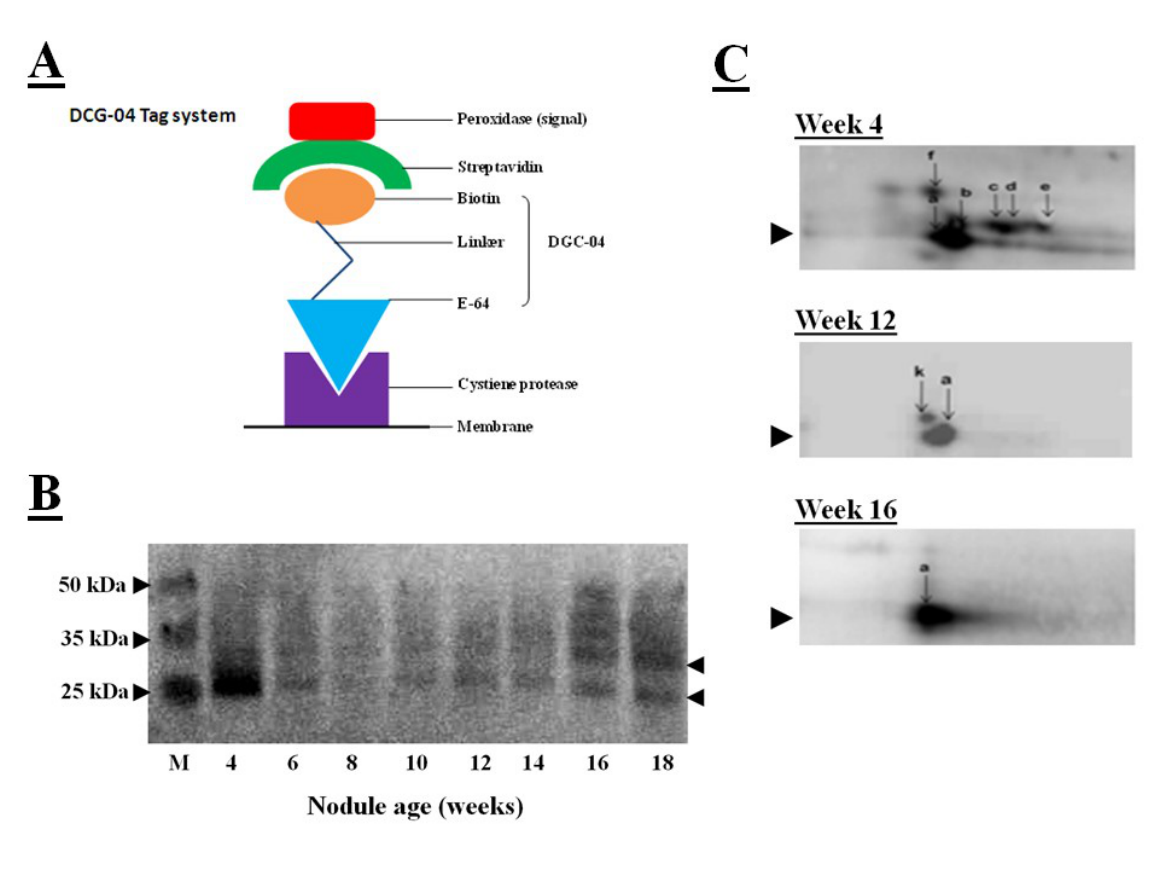
Figure 7. ( A ) Streptavidin-based detection system for cysteine proteases where peroxidase-labeled streptavidin binds to biotin linked with DGC-04 which is an E-64 analogue. DGC-04 binds to the active site of the cysteine proteases allowing detection of DCG-04-bound cysteine proteases via peroxidase activity measurement; ( B ) Detection of DCG-04-labeled cysteine proteases produced in 4 to 18 weeks old soybean crown nodules (cultivar Prima 2000). Arrows on the right indicate position of detected cysteine protease bands. M represents different size protein markers. For labelling and detection of DCG-04 bound cysteine proteases with a streptavidin-based detection system the method described by Martinez et al. [57] was applied with five plant samples pooled; ( C ) Two-dimensional PAGE for detection of DCG-04-labeled cysteine proteases produced in 4 to 16 weeks old crown nodules. For first dimension, acetone precipitated nodule proteins (40 µg) were first added to 130 µL of the sample rehydration solution (8 M urea, 2 M thiourea, 2% CHAPS as a detergent, 50 mM DTT as a reducing agent, 0.02% ampholyte solution, and 5% bromophenol blue as a dye) in order to denature and solubilise the sample proteins for isoelectric focusing using ZOOM IPG Runner system according to the supplier’s instructions (Life Technologies, UK). Second dimension was performed as SDS-PAGE according to Laemmli [43] using a 15% polyacrylamide gel and Bio-Rad mini-protean III apparatus Bio-Rad, UK). Protein spots were blotted onto a nitrocellulose membrane and the membrane was developed using the Thermoscientific enhanced chemiluminescent kit according to manufacturer’s instructions (Thermo Fisher Scientific, USA) and visualized on a Syngene GeneSnap imaging system (Syngene,